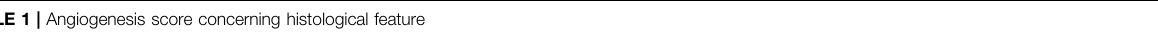
TABLE 1 | Angiogenesis score concerning histological feature Score Histological feature 0